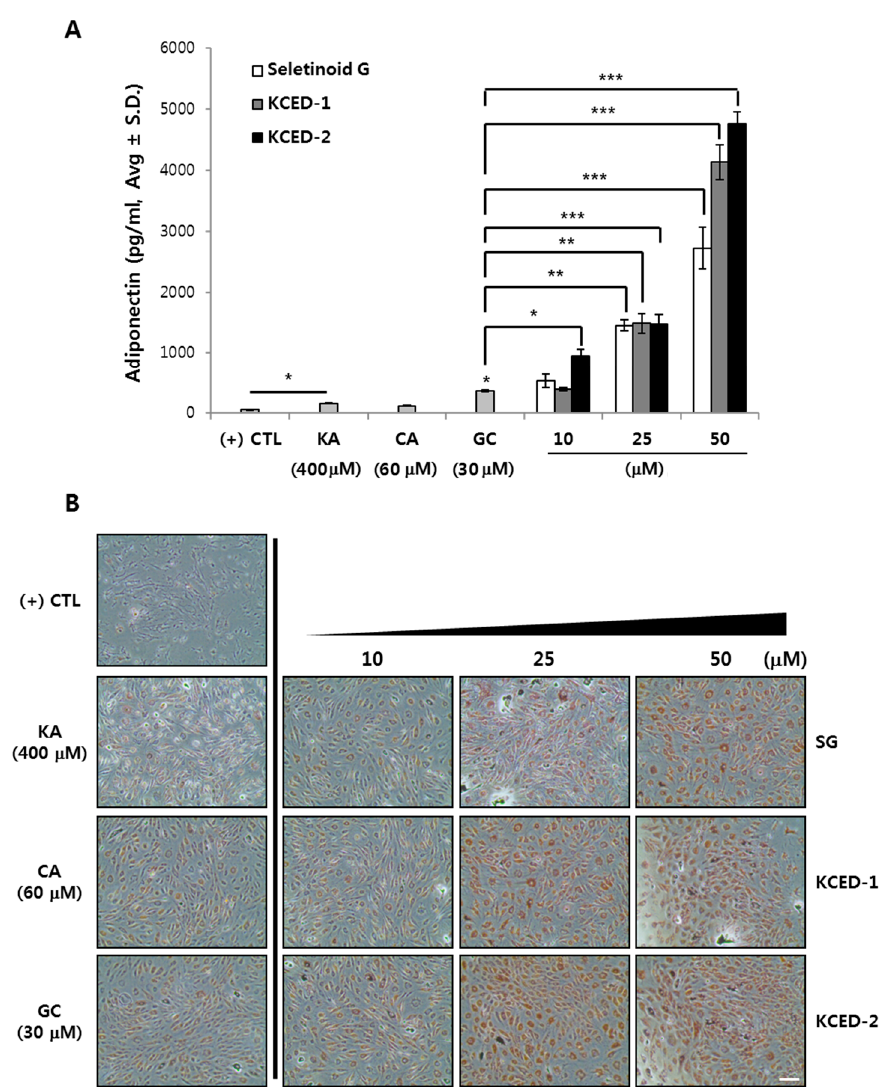
Figure 4. SG, KCED-1, and KCED-2 promote adiponectin secretion and stimulate adipogenesis in hSCFs. The hSCFs were pre-cultured for two days and differentiated for another 14 days using the differentiation medium supplemented with each compound. ( A ) The secreted APN levels were quantitatively determined using ELISA assay kit. The data are presented as the mean ± SD ( n = 3; * p < 0.05, ** p < 0.01, and *** p < 0.001). ( B ) Lipids droplets were stained with Oil Red O dye. Scale bar, 200 μ m.